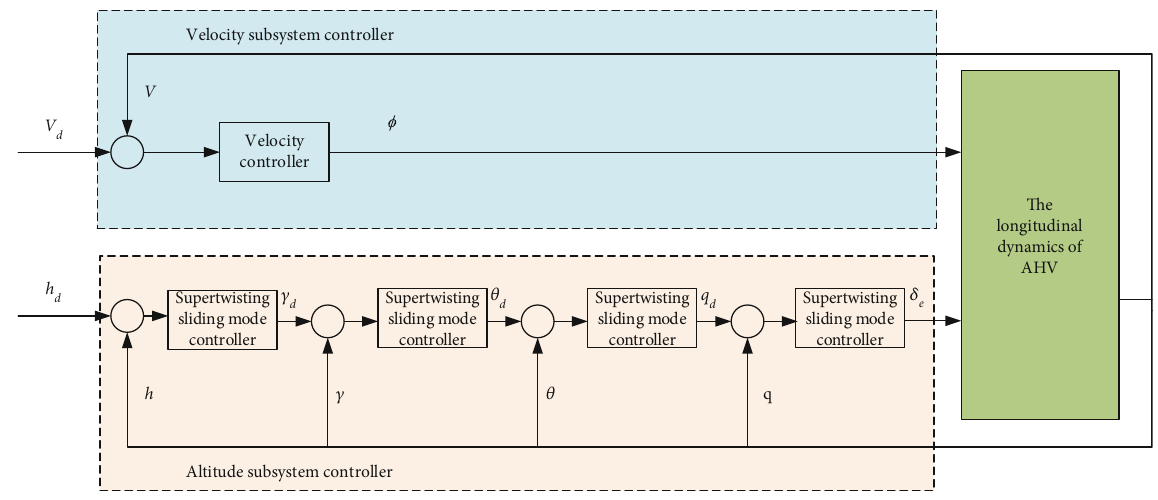
Figure 2: Block diagram of the proposed controller of